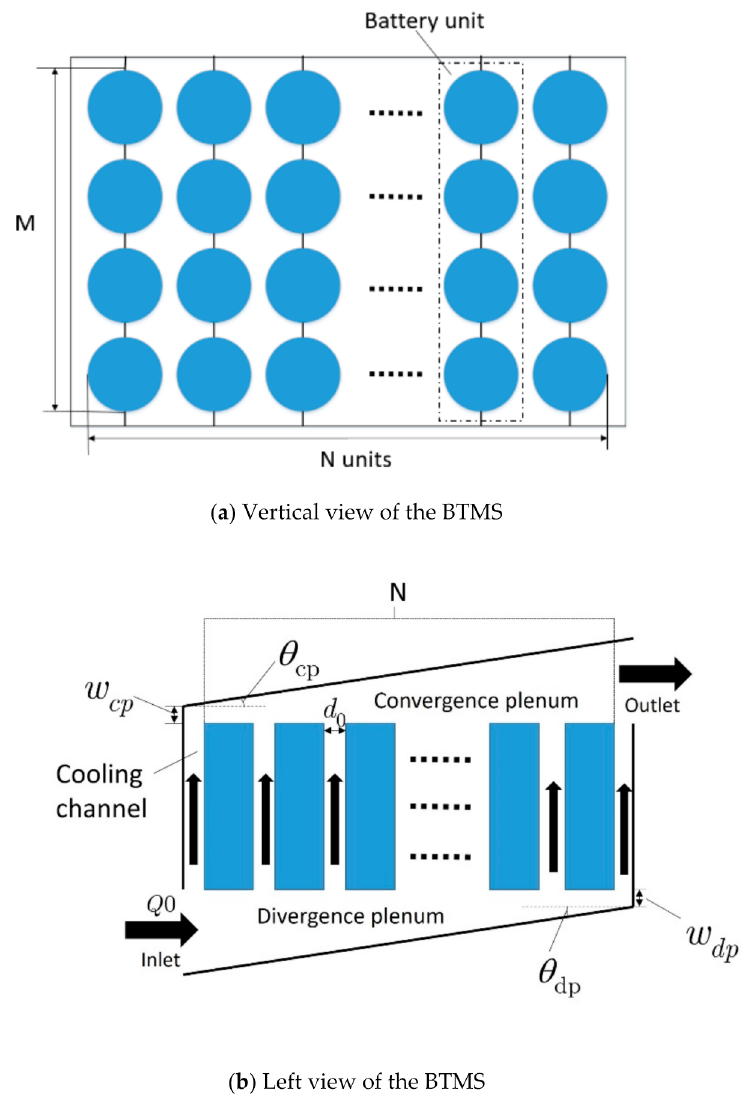
Figure 2. Diagram of the parallel air-cooled